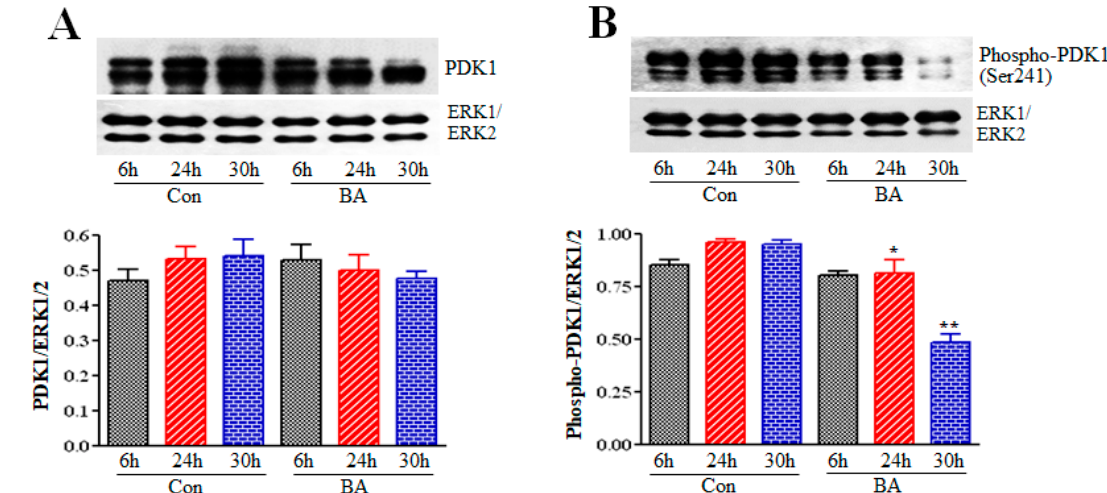
Figure 3. E ff ect of butyrate on PDK1 protein and phosphorylation level in VSMCs. Proliferating VSMCs were treated with (BA) or without (Con) butyrate for indicated periods of time and then cell lysates were prepared. Cell lysates were processed for PDK1 Western blotting to assess the e ff ect of butyrate-inhibited PI3K activity on PDK1 protein and activation levels by measuring total and phosphorylated PDK1 levels, respectively. The data obtained were analyzed and presented as mean ± S.D. ( A ) PDK1 protein level measured by using antibody specific to total PDK1 ( B ) Phosphorylation of PDK1 assessed by using antibody specific to Ser241-phosphorylated PDK1 indicated significant reduction in activation of PDK1 in VSMCs treated with butyrate for 24 h and 30 h (* p < 0.01 vs 24 h control (Con), ** p < 0.001 vs 30 h control (Con).